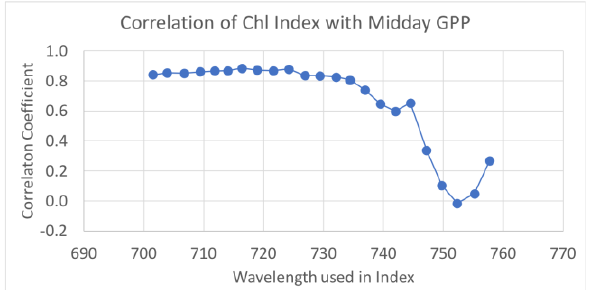
Figure 5 . Correlation coefficients between midday GPP and the chlorophyll index (C i ) using different wavelength bands for the red edge wavelength in Eq. 4. Figure 3 . NDVI from DESIS compared with midday GPP from flux towers. Black points are for US-xWR with open white points being the US-xWR snow covered observations, blue points are for US-xUN, and green points are for US-Ha1 observations.